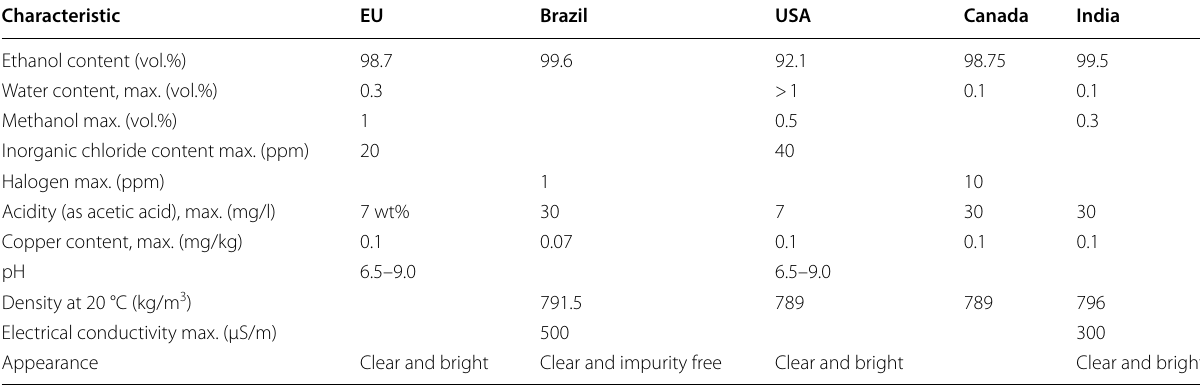
Table 2 Fuel ethanol standards for major ethanol producing countries/region. Modified from Refs. (Costenoble 2017; Kumar et al. 2011, ASTM D4806)